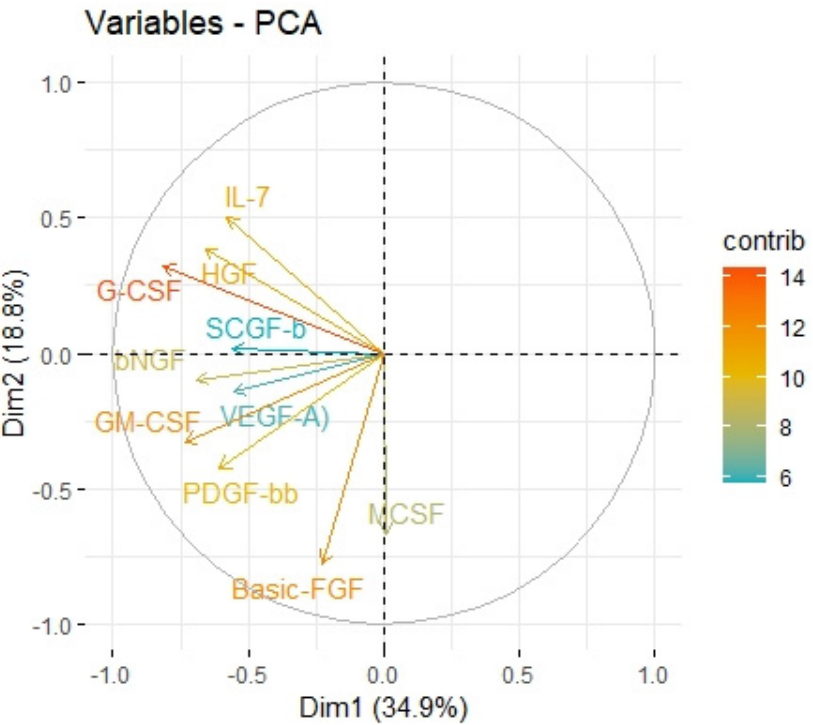
Figure 5. Principal components of protumor growth factors representing variance in two dimensions. PCA loading plot showing PCA of the protumor trophic factors and correlation circle is demonstrated around the PCA. X-axis (Dim1/factor1) is orthogal to y-axis (Dim 2/factor 2). The color and length of vector indicate how strongly each cytokine contributes to principal components/factors (Dim 1 and Dim 2) and how original concentrations of cytokines are associated with their coordinate values. Table 4. Loadings of factors after varimax rotation. Variable